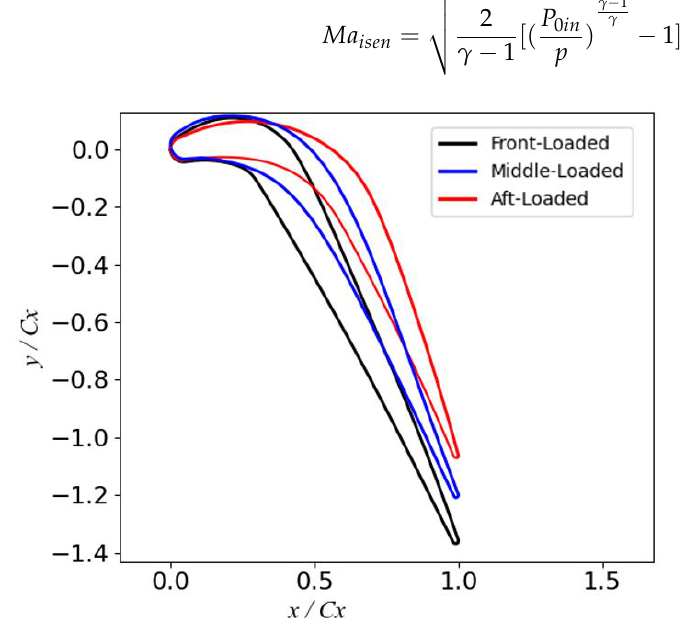
Figure 14. Vane profiles with front-, middle-, and aft-loaded